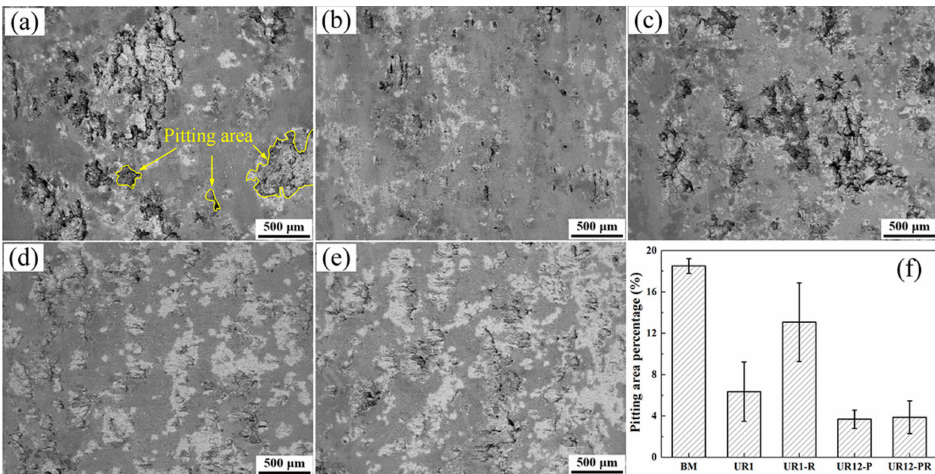
Figure 4. Representative surface SEM backscattered electron images of 7B50 aluminum alloy samples subjected to immersion tests: ( a ) untreated sample, ( b ) UR1, ( c ) UR1 after residual stress relaxation (UR1-R), ( d ) UR12-P, and ( e ) UR12-P after residual stress relaxation (UR12-PR). ( f ) Pitting area